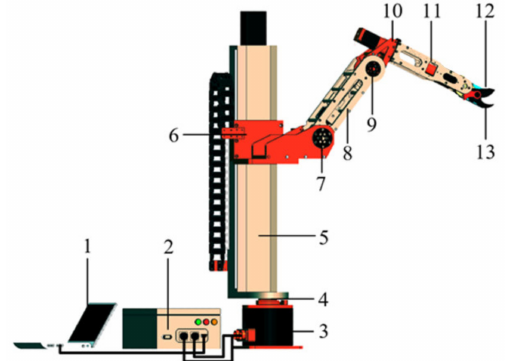
Figure 1. Schematic diagram of the structure composition for the manipulator. 1. PC machine; 2. Control box; 3. Foundation support; 4. Rotary joint of the foundation support; 5. Machine body; 6. Mobile joint of the machine body; 7. Shoulder joint; 8. Big arm; 9. Elbow joint; 10. Rotary joint of the forearm; 11. Forearm; 12. Moving cutter; and 13. Stationary